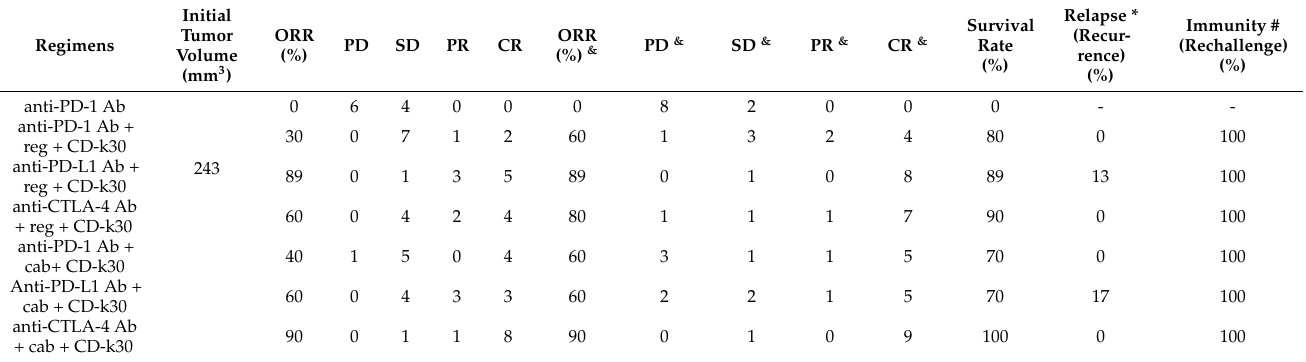
Table 2. Anticancer activities of different ICIs combined with TKIs plus HDAC inhibitor in CT26 tumor-bearing mice